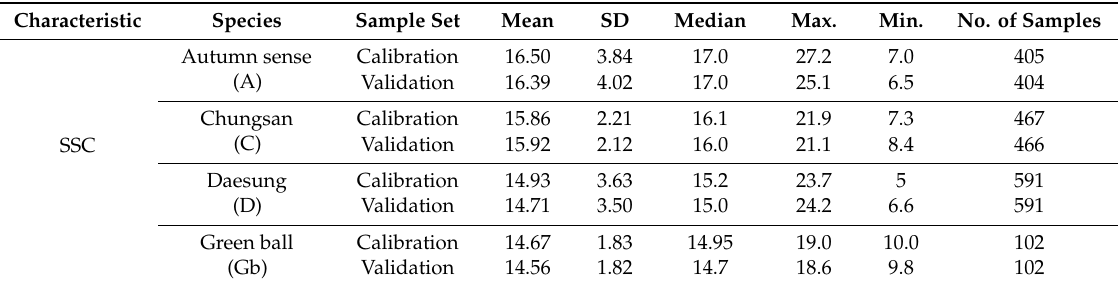
Table 4. Statistical properties of SSC for each species.